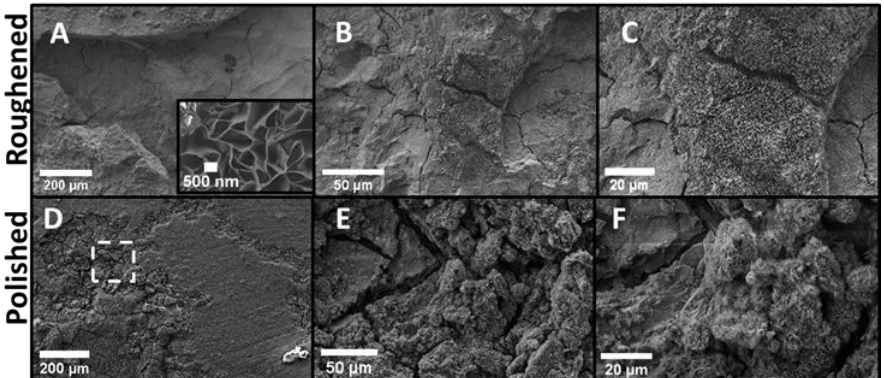
Figure 4. SEM images of the top surfaces for the control and roughened sample. ( A ) roughened sample with inset: highest magnification of flower-like oxide; ( B ) roughened sample at higher magnification, ( C ) roughened sample higher magnification, ( D ) polished sample, ( E ) polished sample at higher magnification, and ( F ) polished sample at highest magnification. The polished sample still had base metal in view with small oxide regions similar to what is seen in ( D ). ( E ) and ( F ) were taken within the dashed box in ( D ) to show the limited oxide for comparison. The roughened sample was uniformly covered in an oxide layer with multiple large craters. There were multiple areas with a flower-like oxide as seen in the inlay of ( A ). This oxide was seen on all three samples in different quantities.